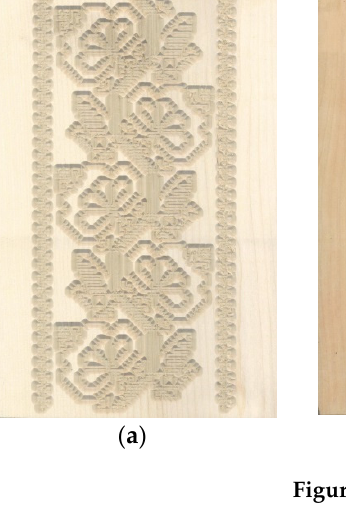
Figure 12. Method of coloring the ornament: ( a ) CNC engraved motif on maple wood; ( b ) colored ornament and lacquered panel ( a ); ( c ) CNC V-carved motif on colored maple wood; ( d ) colored ornament and lacquered panel ( c ).